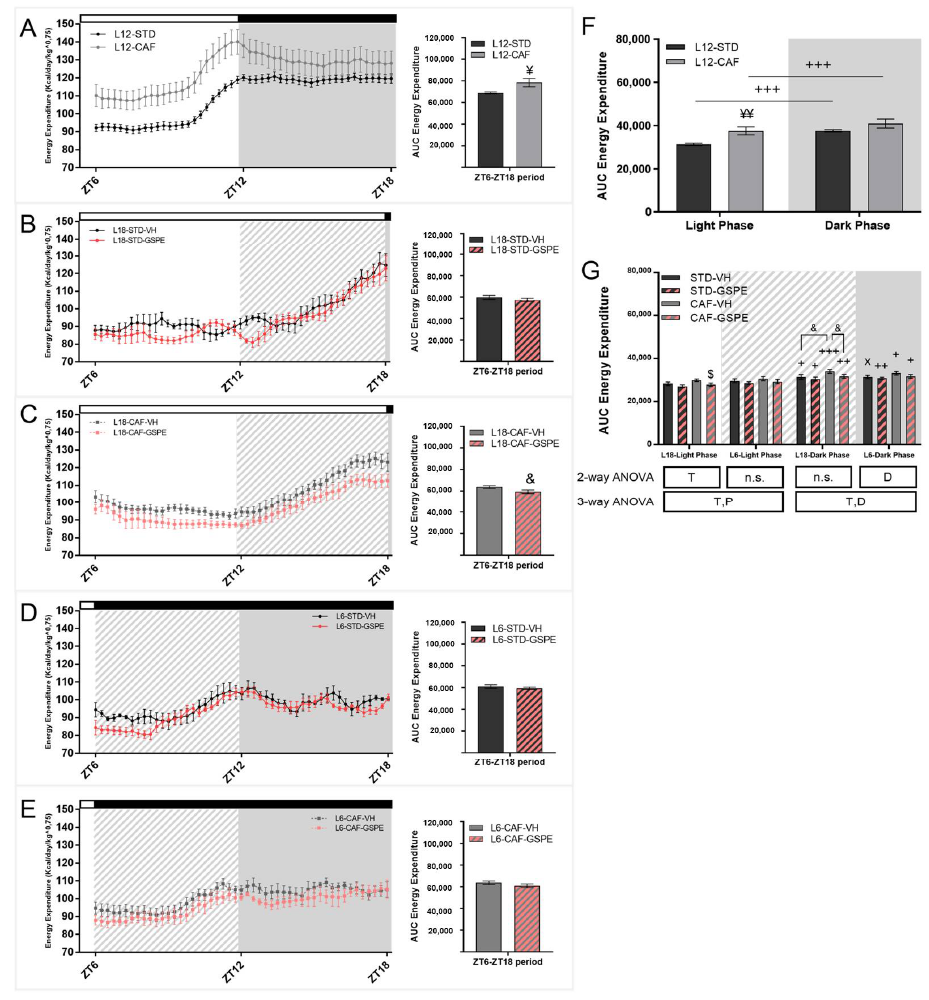
Figure 3. Energy expenditure of STD- and CAF-fed rats in the sixth week of the experiment under L12 conditions and in the seventh week of the experiment under L18 and L6 conditions. ( A ) EE for STD- and CAF-fed rats under the L12 photoperiod and the corresponding AUC. ( B ) EE for STD-fed rats and VH or GSPE administration under the L18 photoperiod and AUC. ( C ) EE for CAF-fed rats administered VH or GSPE under the L18 photoperiod and the corresponding AUC. ( D ) EE for STD-fed rats administered VH or GSPE under the L6 photoperiod and the corresponding AUC. ( E ) EE for CAF-fed rats administered VH or GSPE under the L6 photoperiod and the corresponding AUC. ( F ) AUC of EE for L12 conditions groups. ( G ) AUC of EE for L6 and L18 conditions groups. For L12 conditions values are expressed as the mean ± S.E.M. ( n = 24). ¥ or ¥¥ Indicate significant differences using an unpaired Student’s t -test between L12-STD vs. L12-CAF ( p ≤ 0.05 and p ≤ 0.01, respectively). Values are expressed as the mean ± S.E.M. ( n = 6). D, diet effect; T, GSPE treatment effect; P, photoperiod effect; n.s., no significant differences. $ Indicates significant differences by treatment effect. & Indicates tendency using a LSD post-hoc test ( p = 0.1–0.051). +, ++ or +++ Indicate significant differences using a paired Student ´ s t -test between Light Phase vs. Dark Phase for each group ( p ≤ 0.05, p ≤ 0.01 and p ≤ 0.001, respectively). x Indicates tendency using a paired Student’s t -test between Light Phase vs. Dark Phase for each group ( p = 0.1–0.051). EE, Energy Expenditure; AUC, Area under curve; STD, Standard diet-fed rats; CAF, Cafeteria diet-fed rats; VH, rats administered vehicle; GSPE, rats administered 25 mg/kg grape seed proanthocyanidin- rich extract; L12, standard photoperiod 12 h light per day; L18, long photoperiod 18 h light per day; L6, short photoperiod 6 h light per day. Grey background, dark phase. slash background, transitions